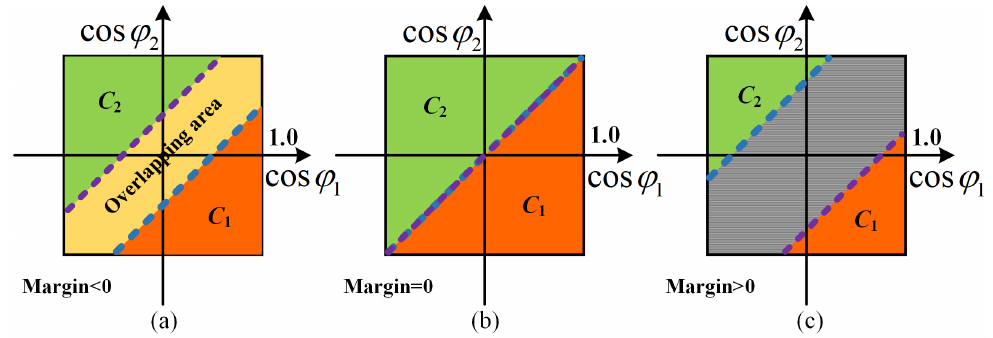
Figure 2. Comparison of decision boundaries of ( a ) softmax, ( b ) cosine softmax loss (CSL), and ( c ) margin cosine softmax loss (MCSL) functions under binary classification. Green and orange regions represent the decision areas of classes C 1 and C 2 , respectively. The yellow region represents the overlapping decision area. Purple and blue dotted lines represent the decision boundaries of classes C 1 and C 2 ,